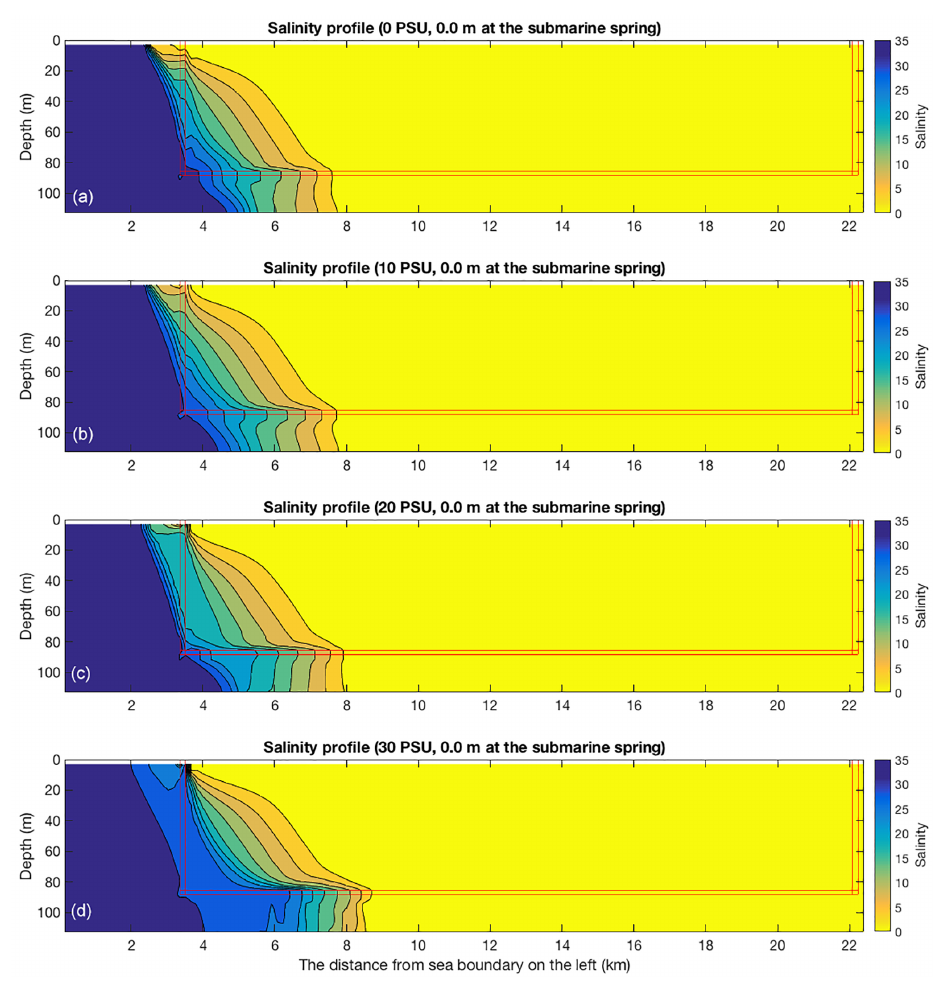
Figure 13. Salinity simulation of seawater intrusion with various salinities at the submarine spring, indicating different rainfall recharge and freshwater discharge conditions: (a) 0.0PSU, 0.0m at the submarine spring; (b) 10.0PSU, 0.0m at the submarine spring; (c) 20.0PSU, 0.0m at the submarine spring; (d) 30.0PSU, 0.0m at the submarine spring (from top to